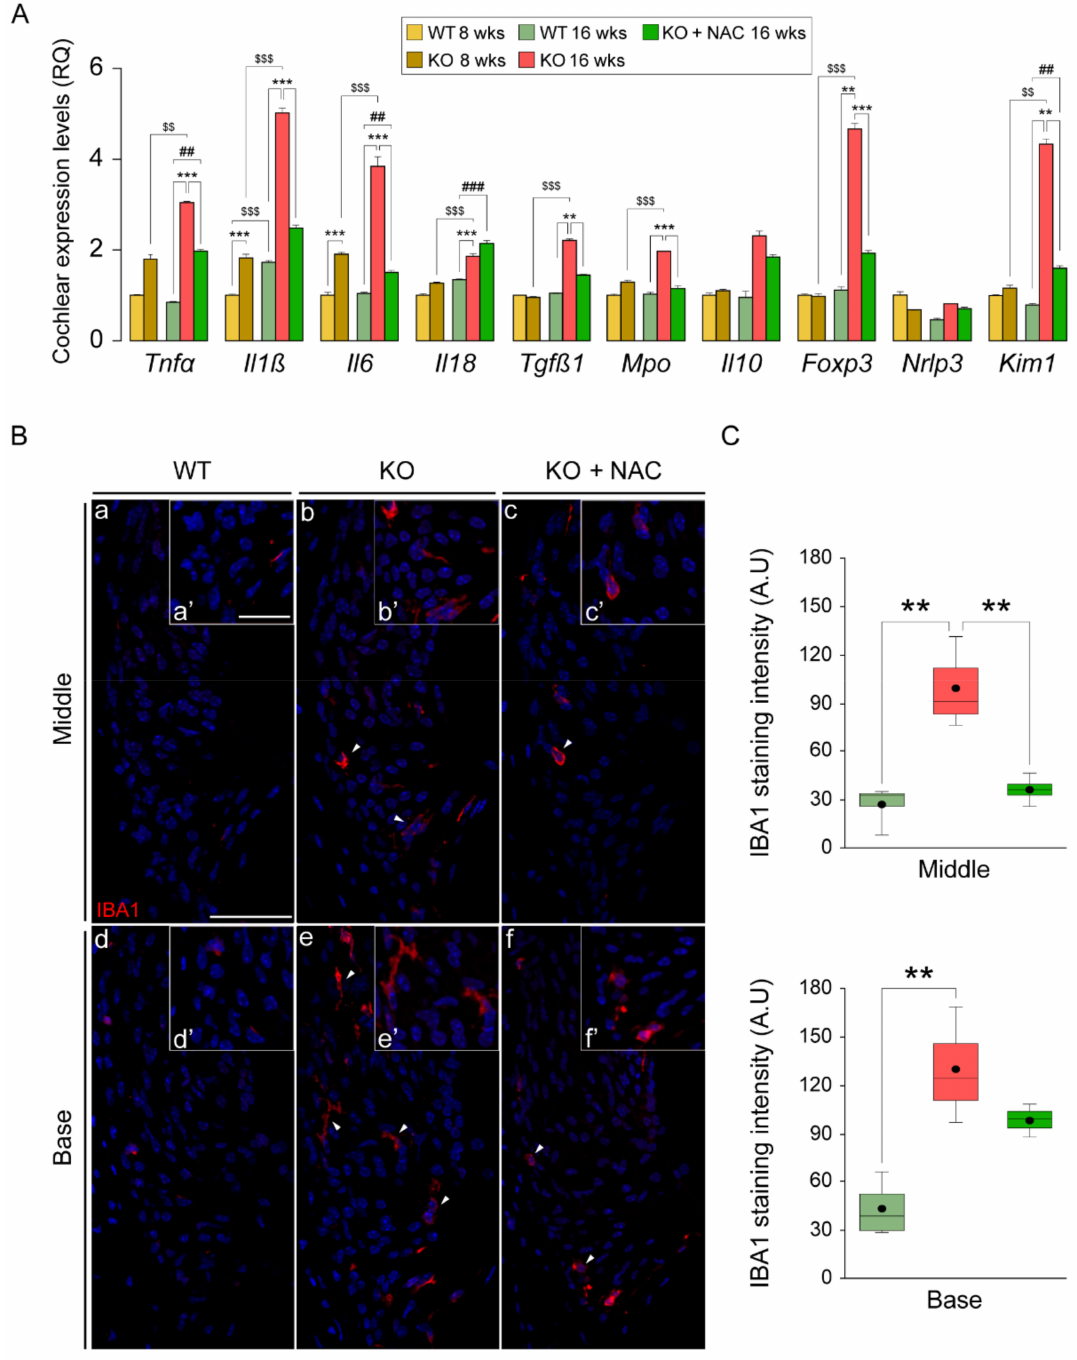
Figure 6. Cochlear exacerbated inflammatory response and macrophage recruitment in Dusp1 − / − mice is limited by N-acetylcysteine administration. ( A ) RT-qPCR gene expression levels of inflammatory mediators from whole cochlea pooled samples from 3 mice per condition. Expression levels were calculated as 2 − ∆∆ Ct (RQ) from triplicate measurements using Hprt1 as a reference gene and normalized to levels in 8-week-old wild-type (WT) mice. Data are presented as mean ± SEM. ( B ) Representative basal and middle turn cochlear spiral ligament (Spl) cross-cryosections of 16-week-old WT, Dusp1 knock-out (KO) and NAC-treated Dusp1 KO mice immunolabeled for IBA1 in red (a–f). Arrowheads highlight positive macrophages staining. Spl close ups (a’–f’). Scale bar: 40 µ m in a and 25 a’. ( C ) IBA1 quantification in the spiral ligament. Staining intensity was quantified in 3 mice per condition in at least 3 serial sections per turn. Data are presented as a box plot, mean value is plotted as a filled circle and whiskers represent min and max values. Statistical significance between genotypes and time points was analyzed by one-way ANOVA: * vs. KO, # vs. WT, $ 8-week-old mice vs. 16-week-old mice (**, ##, $$ p < 0.01; ***, ###, $$$ p <